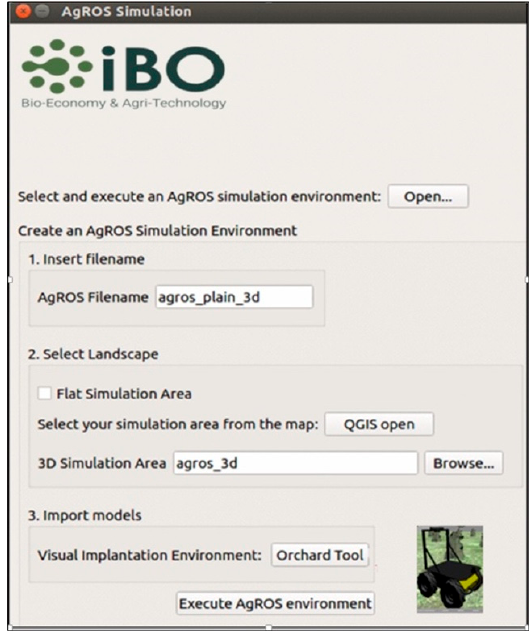
Figure 4. AgROS graphical user interface.